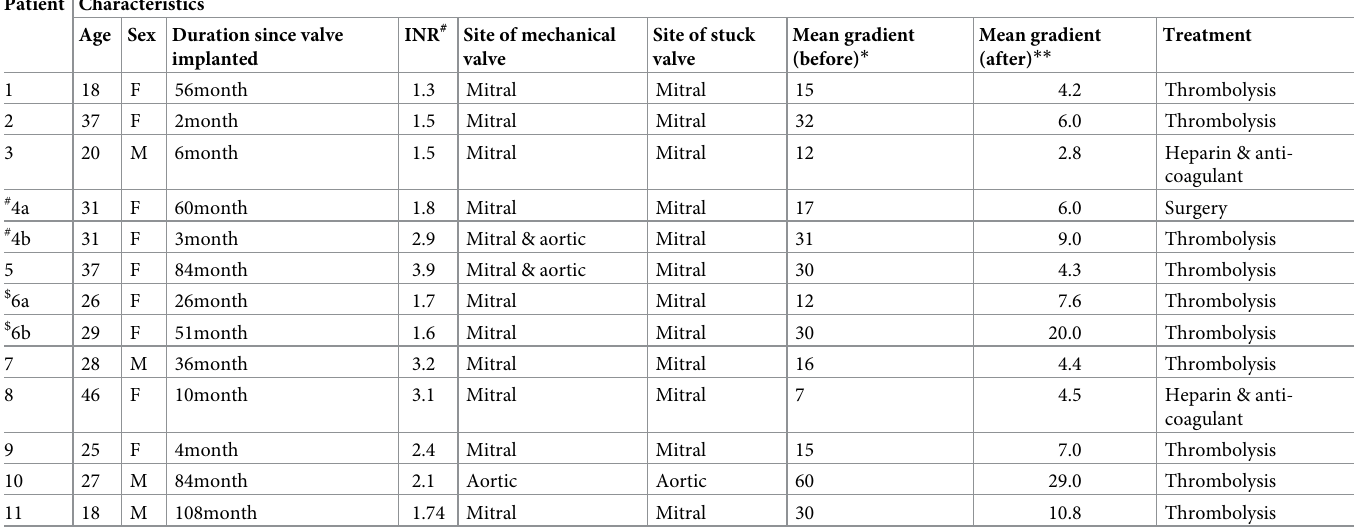
Table 1. Clinical and echocardiographic characteristics of patients with mechanical stuck valve,